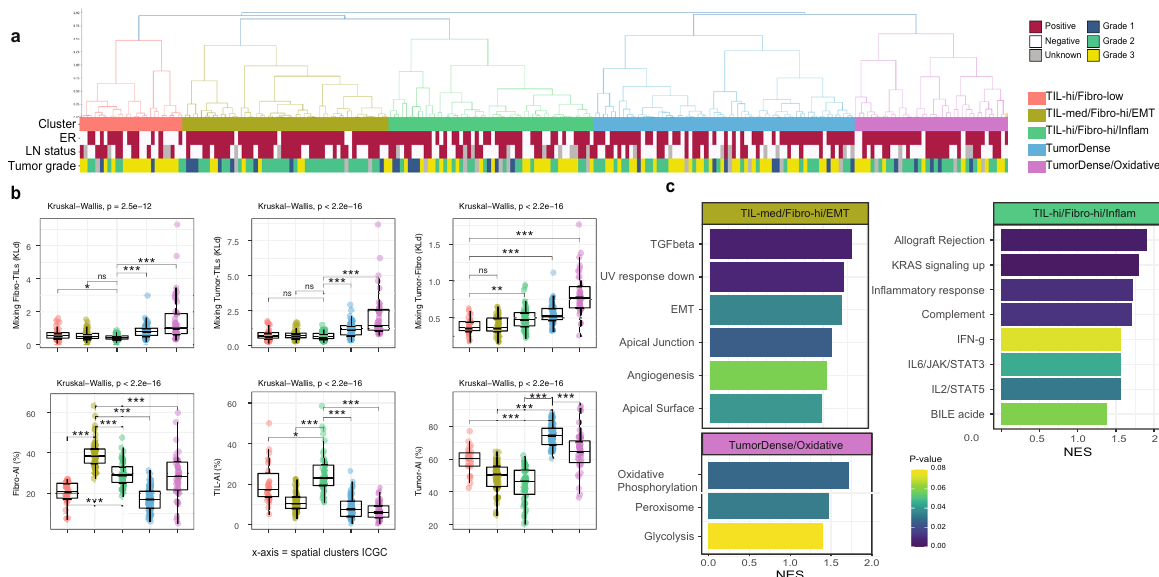
Fig. 3 Hierarchical spatial clustering of ICGC breast tumors results in biological distinct groups. a Dendrogram of the hierarchical clustering of the ICGC cohort ( N = 235) with annotated clinical parameters. b Boxplots of the six spatial H&E measurements that were used for the clustering. Box plots show median, lower, and upper hinges correspond to the 25th and 75th percentile. Y -axis shows KLd (three upper graphs) and percentages (three lower graphs). Kruskal – Wallis test and Wilcoxon-rank test for comparing the highest in fi ltrated or most mixed cluster to the rest. * P < 0.05; ** P < 0.01; *** P < 0.001; **** P < 0.0001; NS not signi fi cant by Wilcoxon-rank test. c The normalized enrichment score (NES) for the hallmarks of cancer gene sets for each of the fi ve spatial clusters (ER + HER2 − samples only, N = same patterns. This indicates that e.g., an ER + and ER − tumor in the same spatial cluster indeed shows similar cell in fi ltration, but the cluster itself may be enriched for ER + breast tumors.